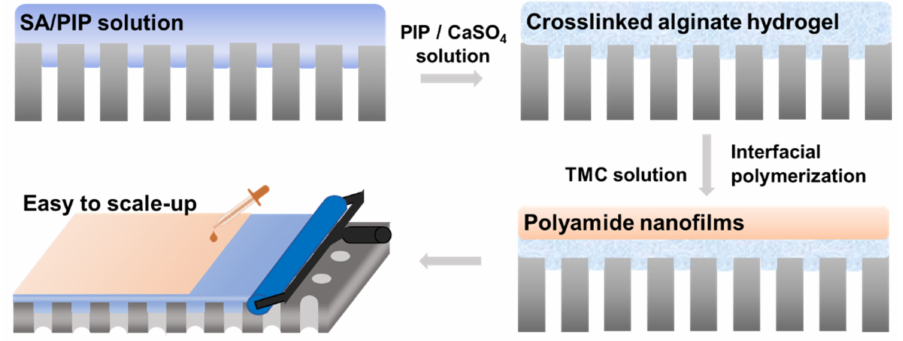
Figure 1. Schematic of an easy to scale-up approach to prepare nanofiltration membranes by building an alginate hydrogel reaction intermediated layer with a one-step crosslinking